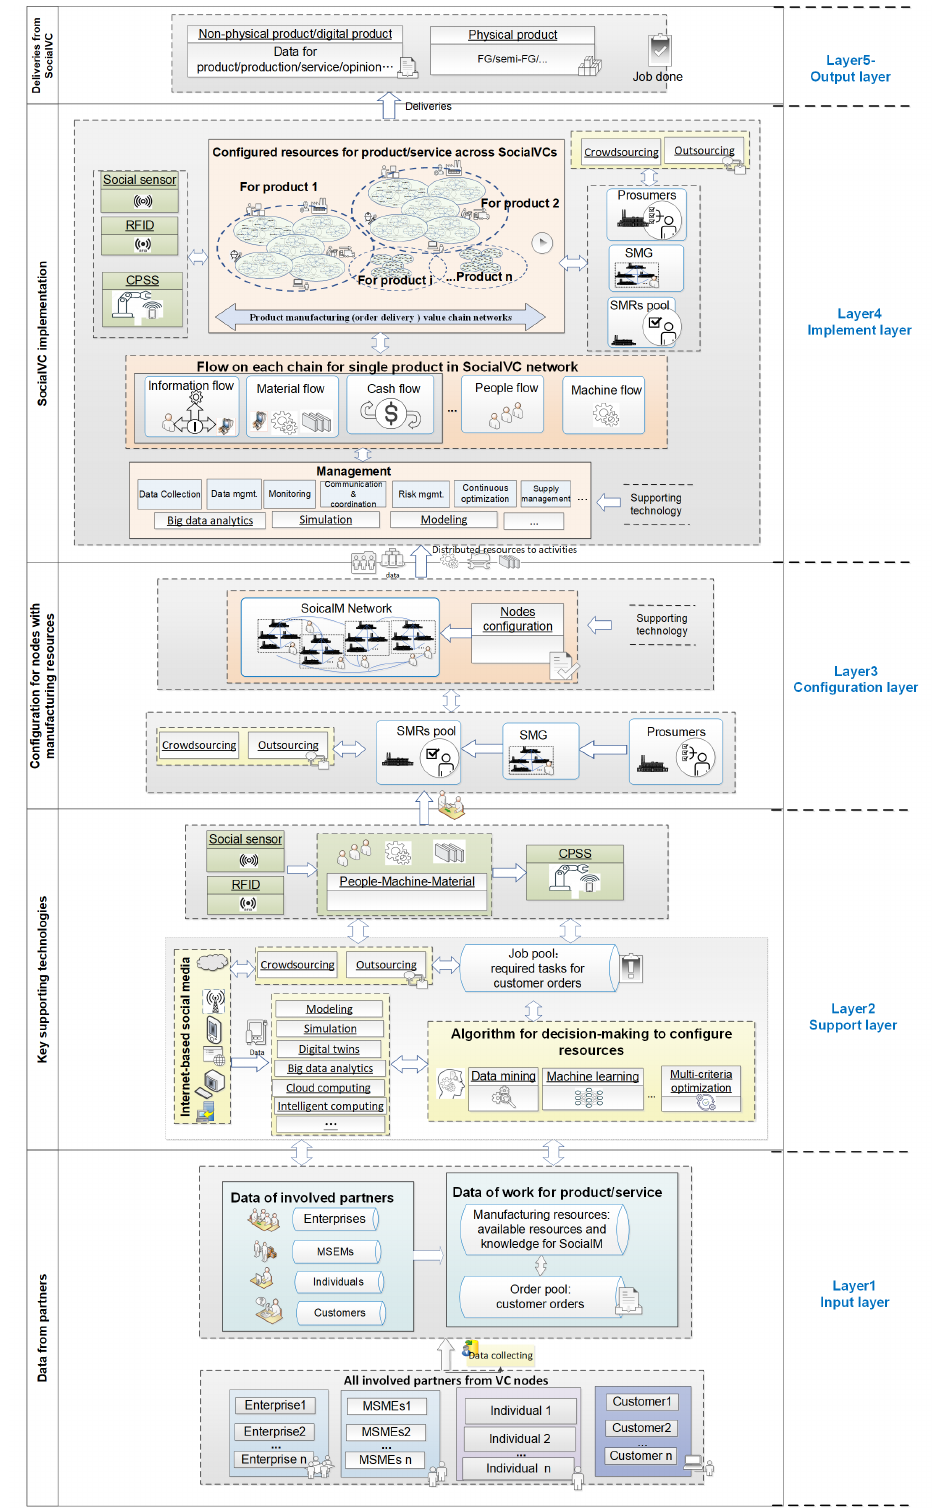
Figure 4. Architecture of the SocialVC